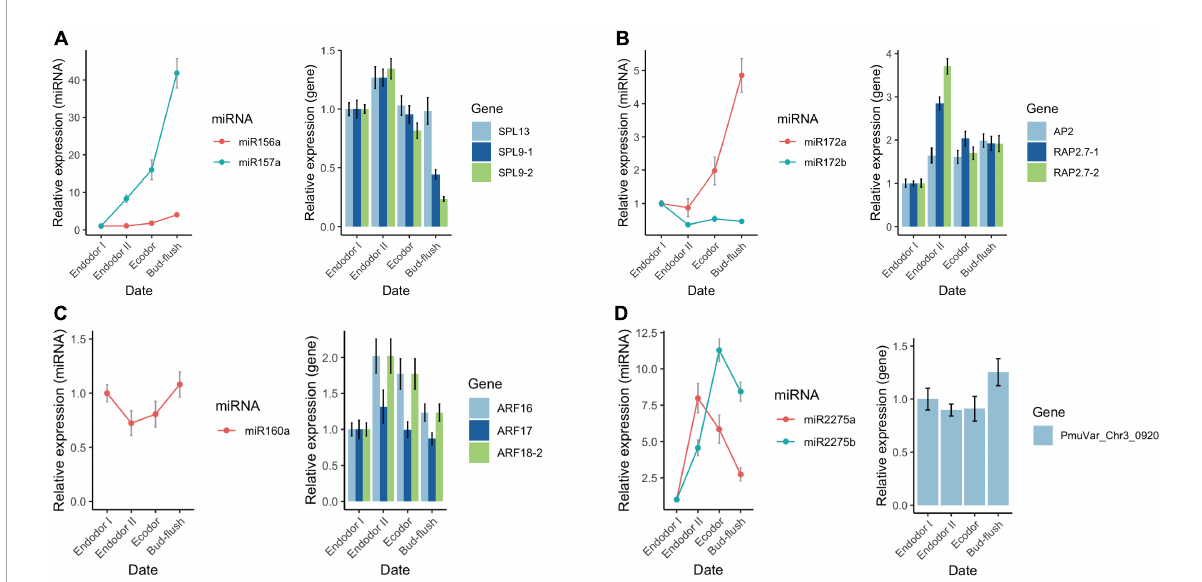
FIGURE9 qRT-PCR analysis of the expression pattern of DEGs and DEmiRs during floral bud break in P. mume . The relative expression level of miRNAs within miR156/157 family (A) , miR172 family (B) , miR160 (C) , and miR2275 (D) were analyzed across four developmental stages using 5S rRNA as internal reference. Similarly, the relative expression level of their corresponding target genes were analyzed with PP2A as reference gene in the qRT-PCR